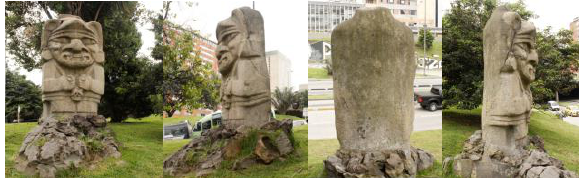
Figure 1. Taking photographs front, side and back of the Sculpture San Agustin No. 28.